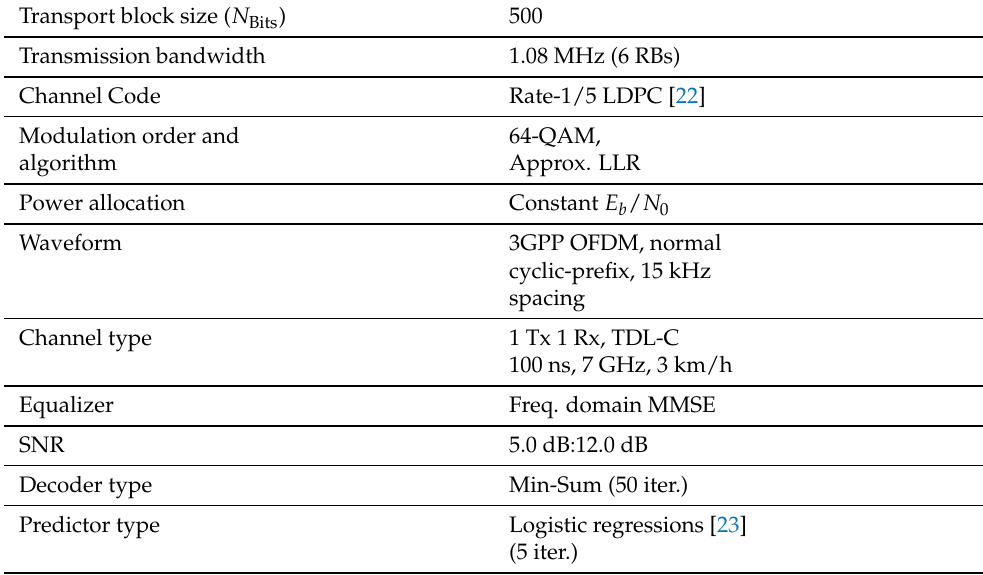
Table 2. LLS assumptions for training and test set